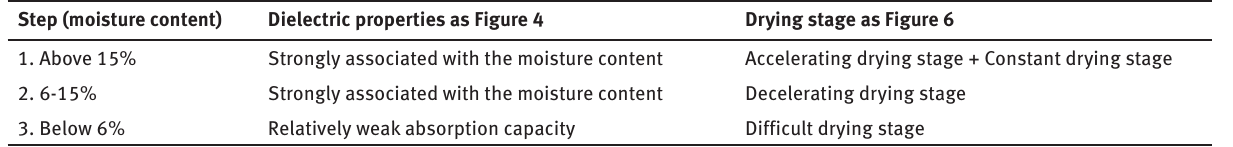
Table 4: Microwave drying stage division.